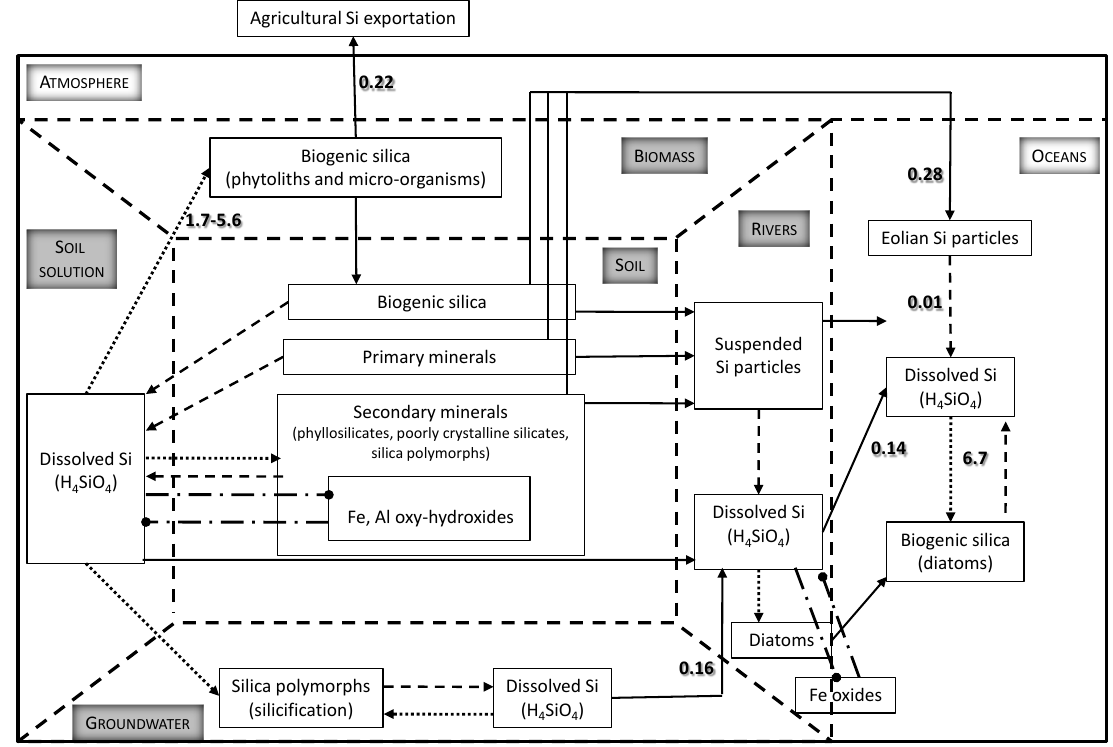
Fig. 1. Biogeochemical Si cycle on continents (compartments modified from Basile-Doelsch et al., 2005). Solid line: transport; dashed line: dissolution; small dotted line: neoformation/precipitation; pointed-dotted line: adsorption/desorption. Numbers on arrows show inter-pool Si transfers in 10 12 kgSiyr − 1 (Tr´eguer et al., 1995; Matichenkov and Bocharnikova, 2001).